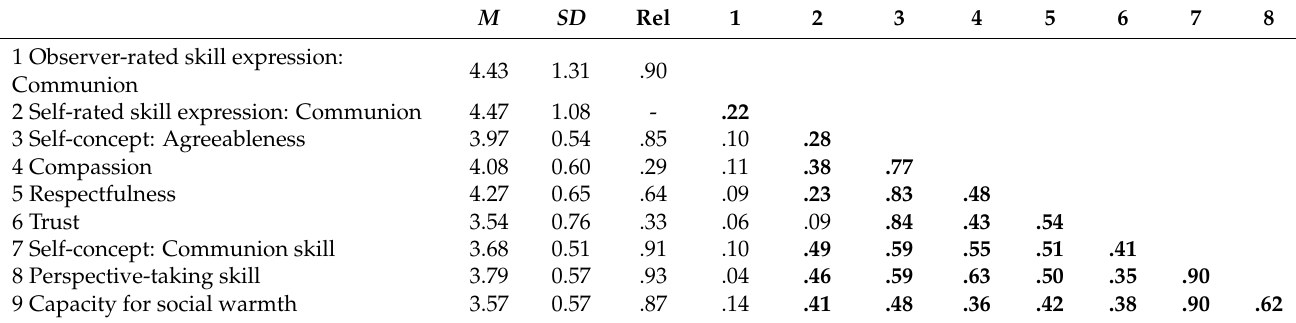
Table 4. Relationships of Skill Expression With Personality and Skill Self-Concepts: Communion.